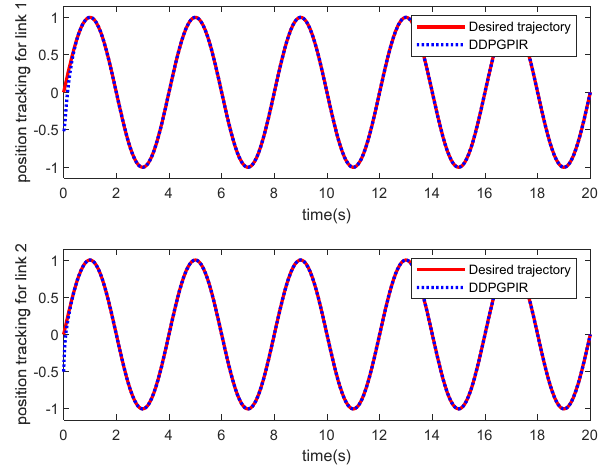
Figure 9. Trajectory tracking performance of DDPGPIR.